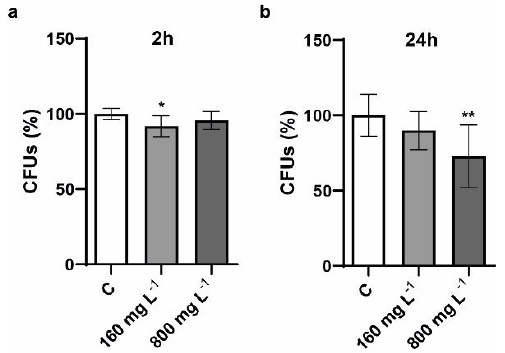
Figure 3. Colony forming unit (CFU) determination of S. cerevisiae cells exposed to 160 and 800 mg L −1 of CNTs for 2 hours ( a ) and 24 hours ( b ). The control condition corresponds to non-exposed S. cerevisiae cells. The reported values are the averages of nine biological replicates per culture condition. Differences were established using a One-way ANOVA followed by Tukey’s multiple comparisons test, to compare every mean with the control and considered significant at p ≤ 0.05. * p ≤ 0.05, ** p ≤ 0.01.